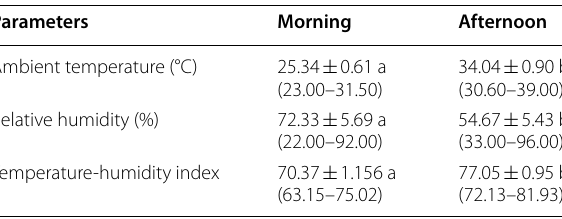
Values with a, b are significantly different P < 0.05